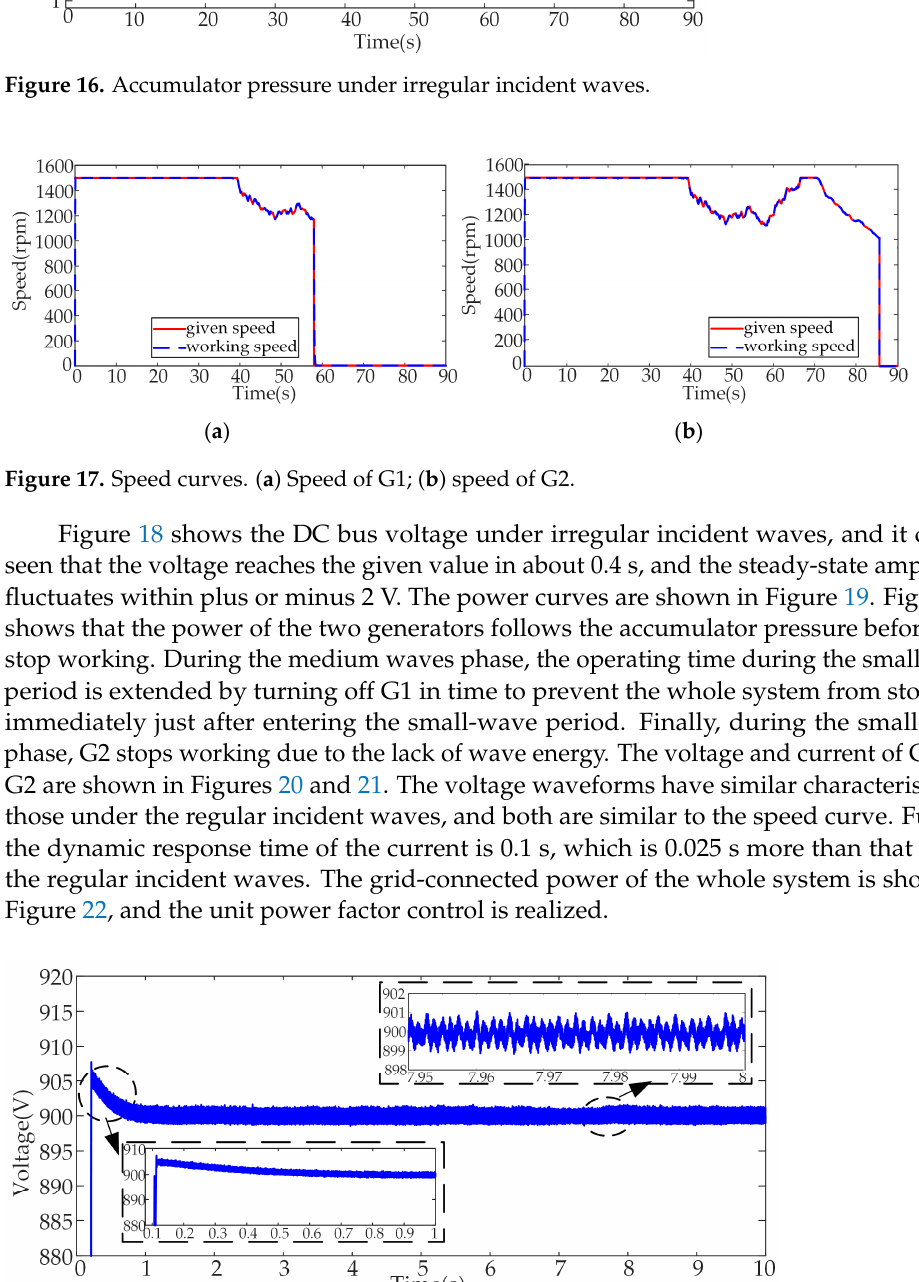
Figure 16. Accumulator pressure under irregular incident waves.